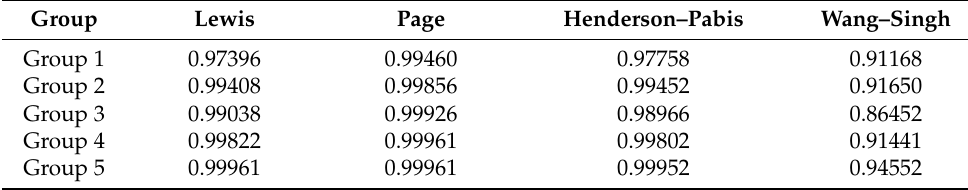
Table 6. Model-fit determinable coefficient ( R 2